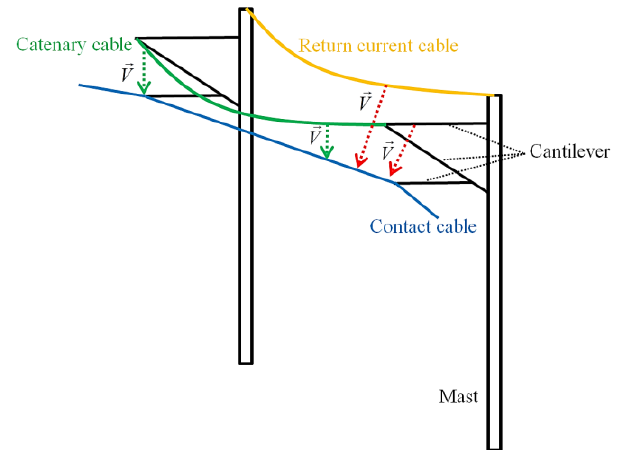
Figure 10. Vectors connecting points on a catenary cable to a contact cable (green arrows) are vertical, while vectors connecting other objects to a contact cable (red arrows) are not